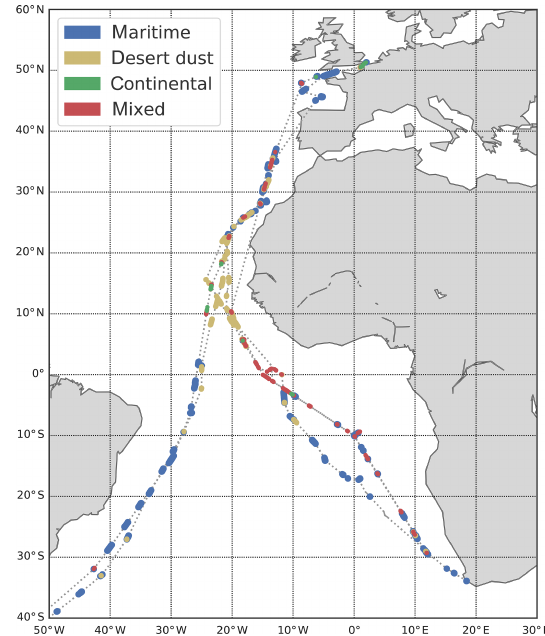
Figure 2. Cruise tracks of the Polarstern during PS83, PS95, PS98, PS102, and PS113. The resulting aerosol type classification ob- tained from the GUVis observation is shown by colour